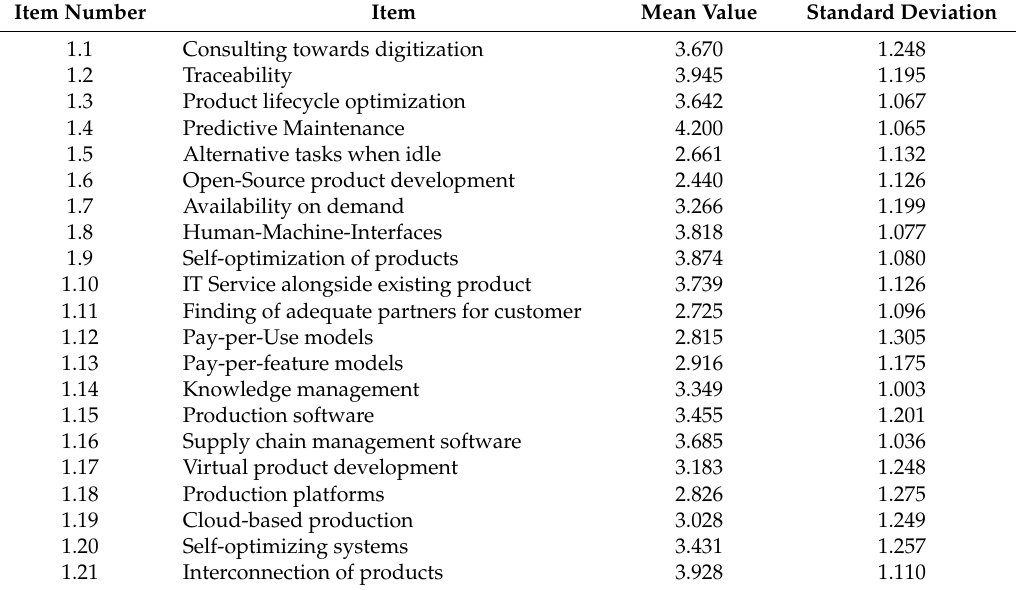
Table A1. New service business model features to offer to the